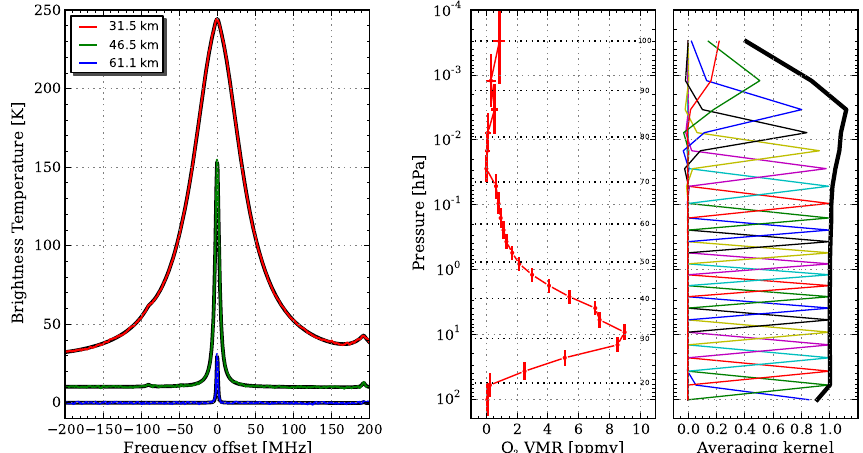
Fig. 2. An example of O 3 retrieval from a single-scan measurement. Left panel shows the measured spectra from tangent heights of 31.5, 46.5, and 61.1km, and the fitted synthesis spectrum (gray line behind the red, green blue lines). An offset of 10 and 20K is added for the two higher tangent height spectra, respectively. Middle panel shows the retrieved O 3 profile with vertical and horizontal bars indicating the vertical resolution and 1 σ retrieval error (sum of the measurement and smoothing errors). The small numbers at the right represent the corresponding altitude in km. Right panel shows the averaging kernels of the retrieval (colored lines) and the measurement response (thick black line).